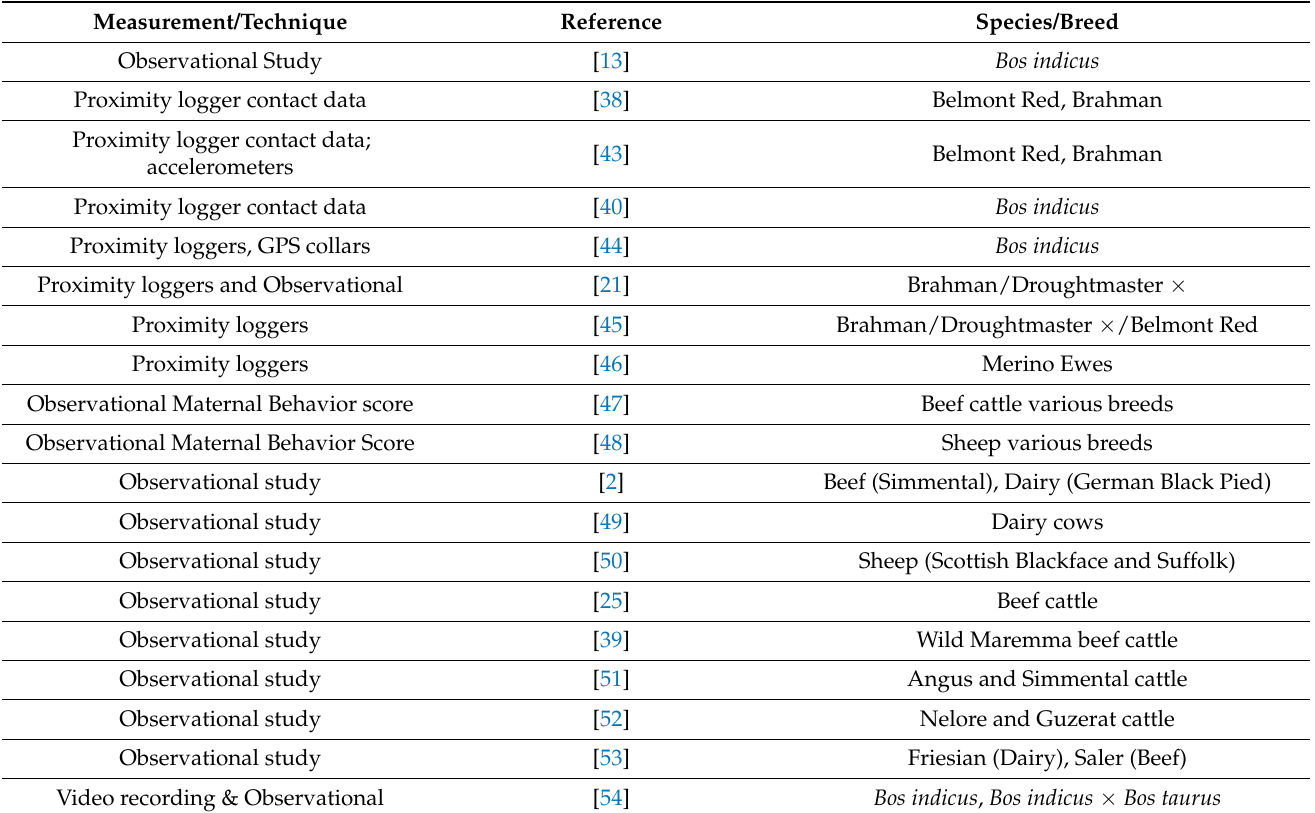
Table 1. Summary of methods and techniques used to investigate maternal behavior in ruminant